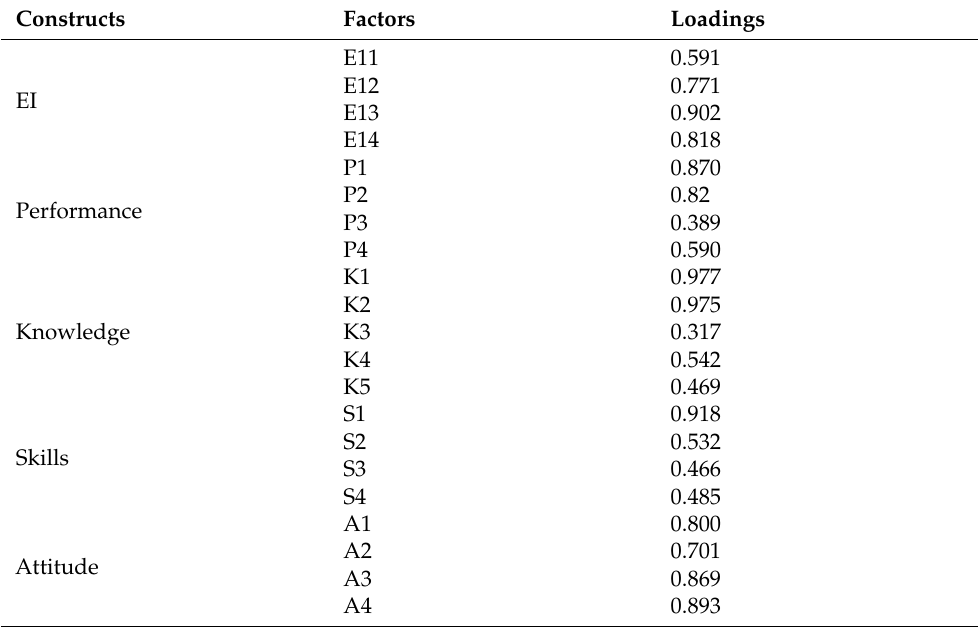
Table 5. Results of Convergent Validity Analysis (Factor